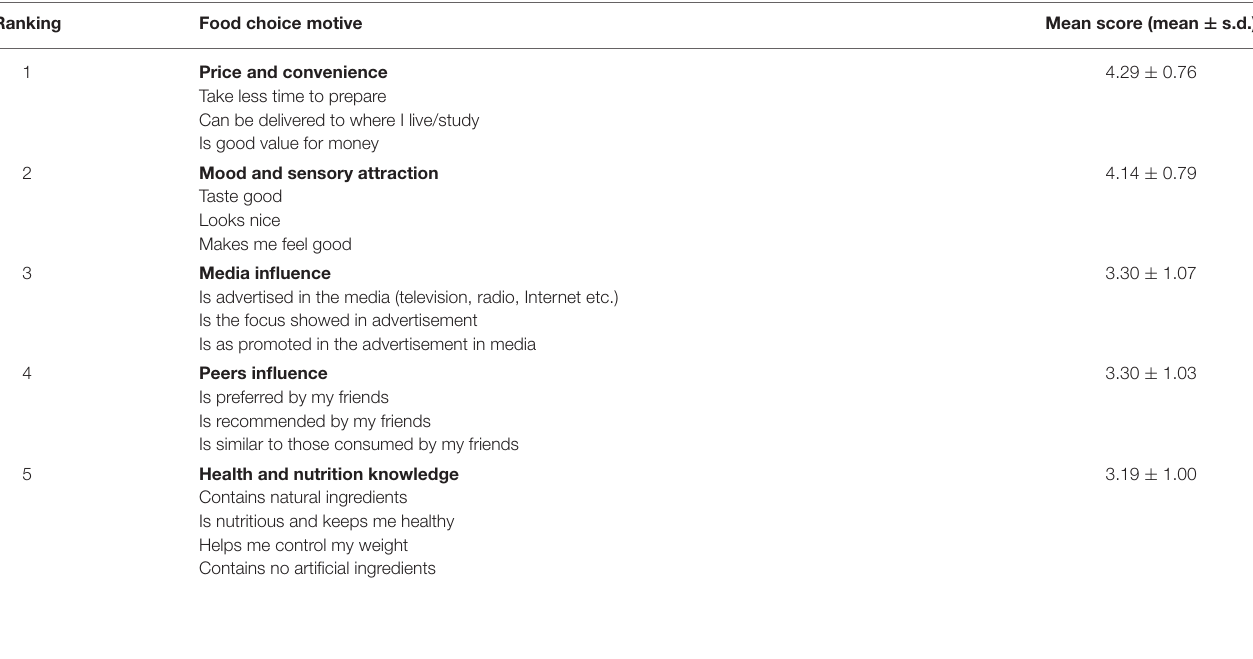
TABLE 4 | Factors affecting food choice in OFD